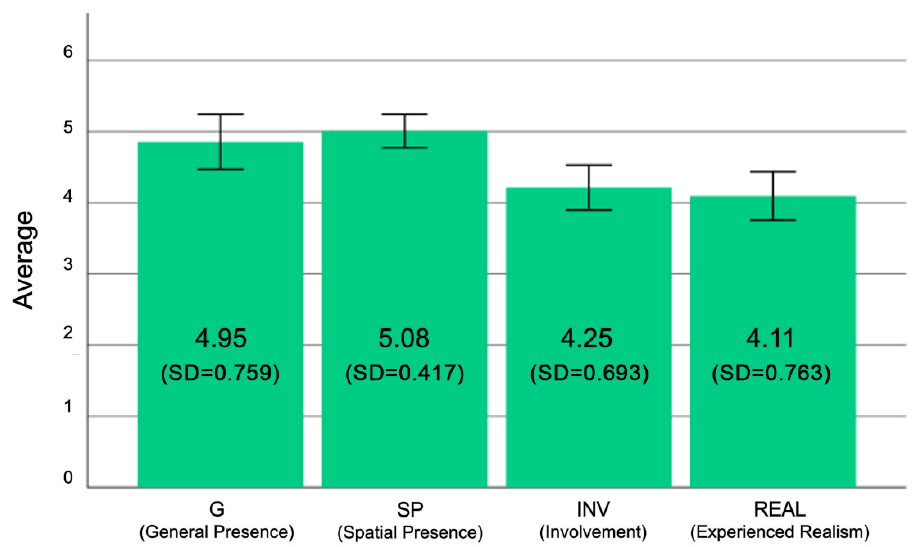
Figure 8. Average result of response for each IPQ